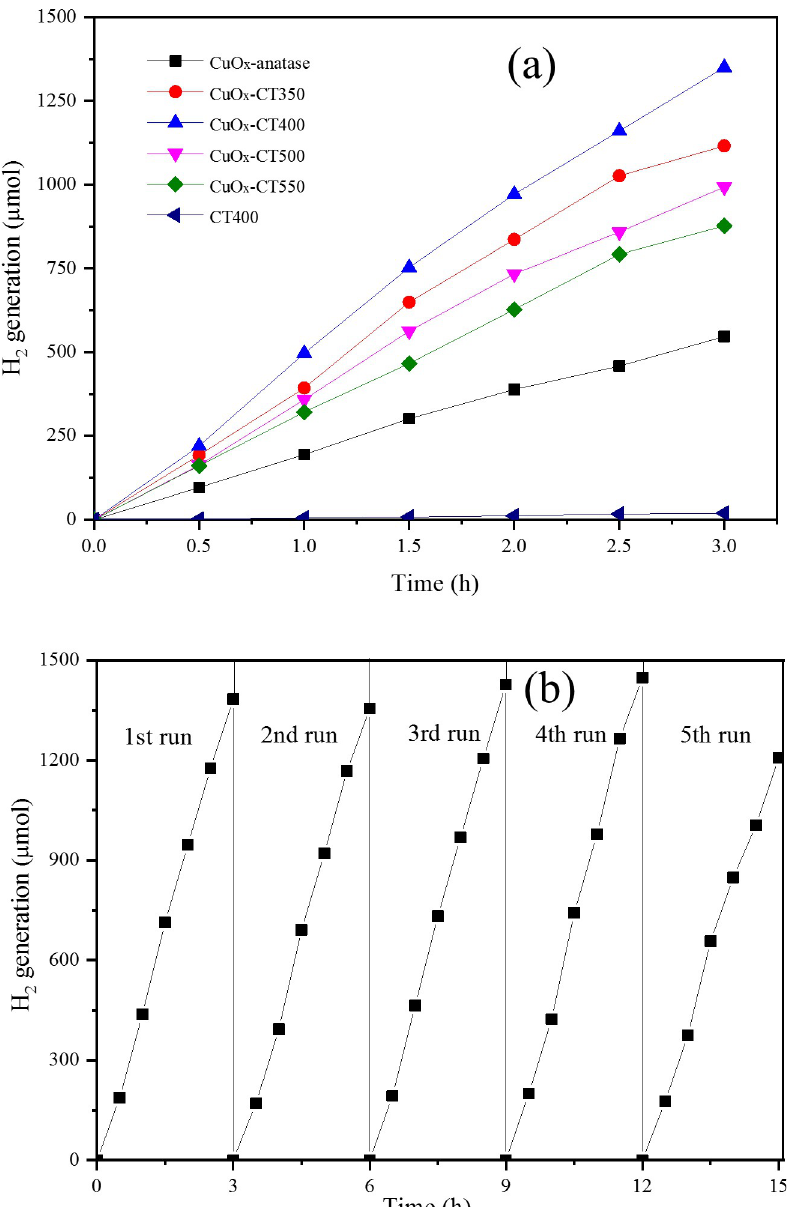
Fig 10. Photocatalytic activity experiment (a) and cycle experiment for CuO